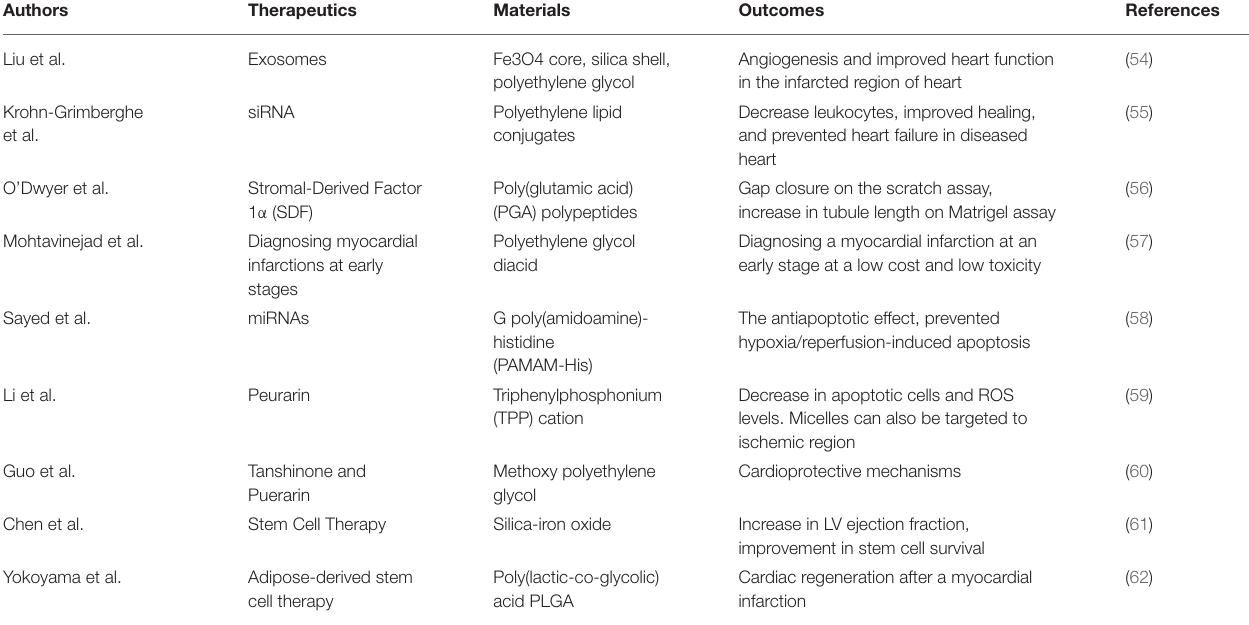
TABLE 1 | Studies highlighting the nanoparticle based formulations delivering therapeutics like miRNA, proteins and small molecules for cardiac